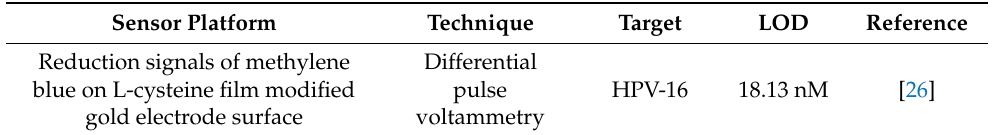
Table 2. Comparison of limit of detection (LOD) of other previously reported HPV-16/HPV-18 electrochemical DNA